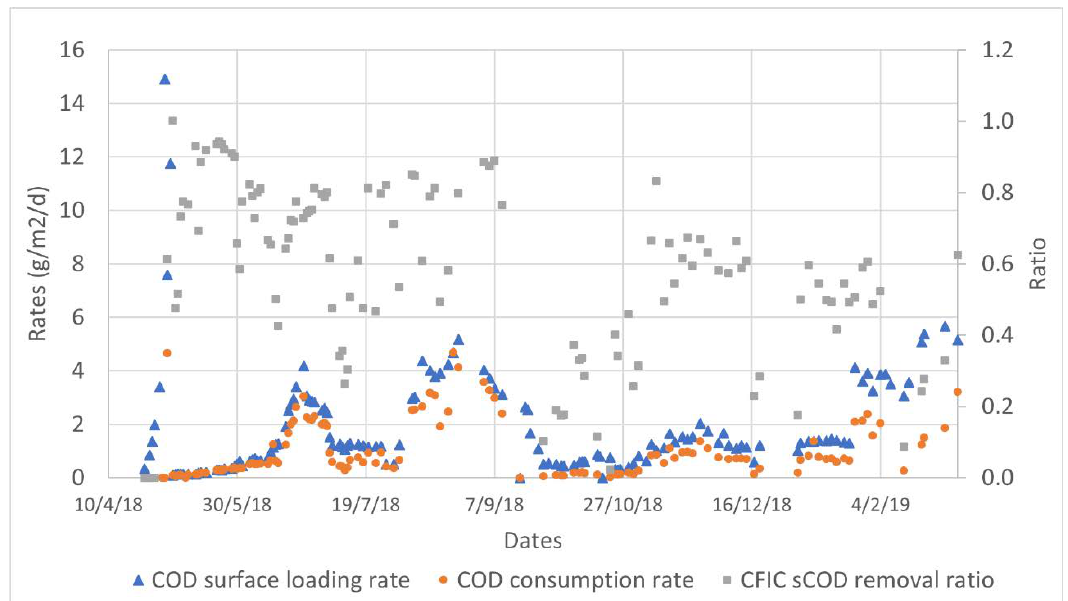
Figure 10. COD loading and consumption as a function of the protected surface area of the biocarriers and the removal efficiency.